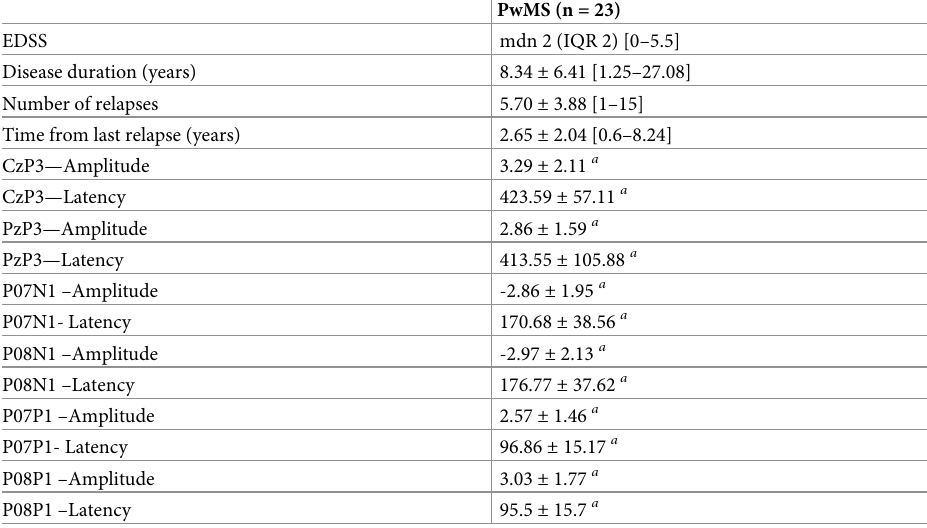
Table 2. Clinical and physiological (ERPs) features of pwMS.